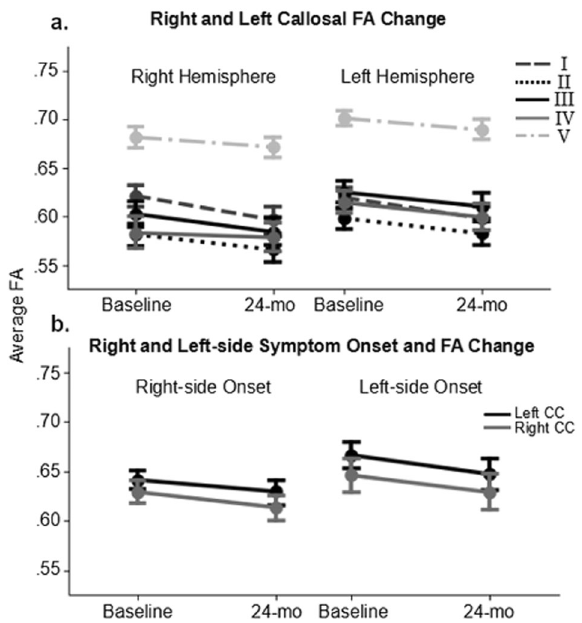
Fig. 3 Lateralized and onset-based callosal microstructural changes. a Change in FA of the left and the right hemisphere of the corpus callosum over two years. Each line indicates a different callosal segment. b Changes in FA in the left and right hemispheres of the corpus callosum for subjects with left and right symptom onset. I = prefrontal section; II = premotor section; III = motor section; IV = somatosensory section; V = temporal-parietal-occipital